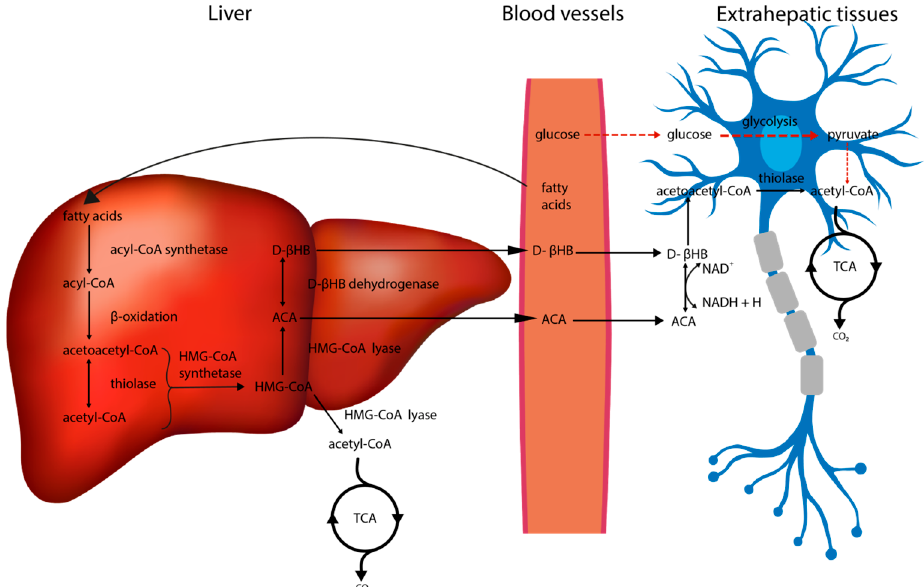
Figure 2. Ketogenesis. Fatty acids undergo the process of β -oxidation in the liver, resulting in the formation of ketone bodies. These are then transported to the blood vessels and then to the neurons where, after conversion to acetyl-CoA, they enter the TCA cycle. The alternative energy source com- pensates for the smaller contribution of glucose to the ATP yield. (HMG-CoA: 3-hydroxy-3-methyl glutaryl-CoA; HMG-CoA synthetase: 3-hydroxy-3-methyl glutaryl-CoA synthetase; HMG-CoA lyase: 3-hydroxy-3-methyl glutaryl-CoA lyase; ACA: acetoacetate; D- β HB: D- β -hydroxybutyrate; TCA: tricarboxylic acid cycle).